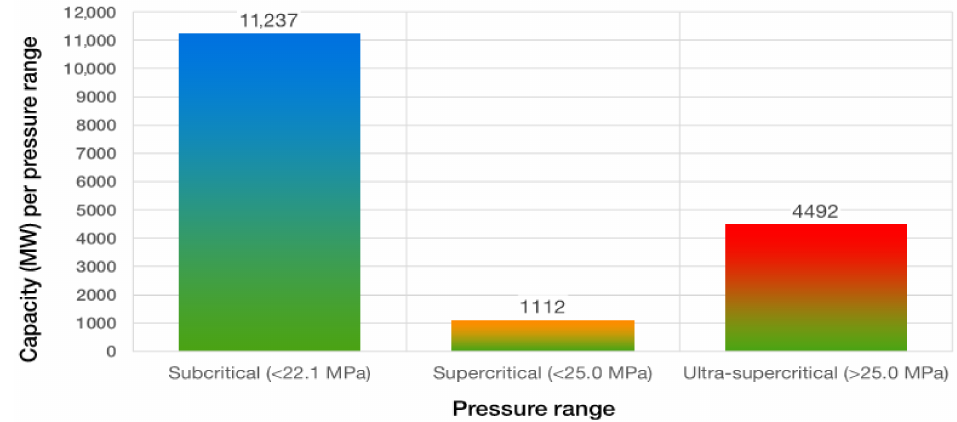
Figure 5. Live steam pressure in large, modern, or modernized Polish coal power plants.